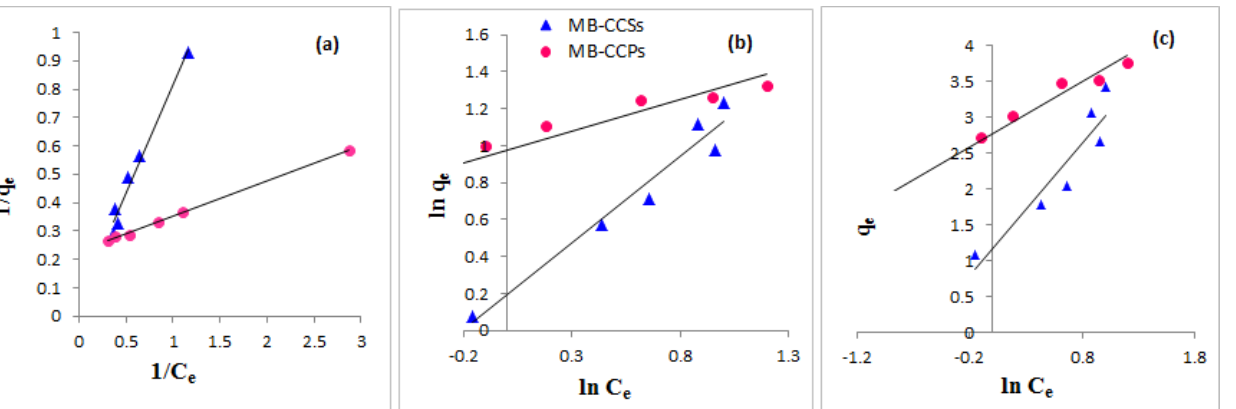
Figure 9. Adsorption Isotherm models: ( a ) Langmuir, ( b ) Freundlich, ( c ) Temkin. By analyzing these results, it was noted that the Langmuir model presented the best fitness for MB-CCSs system pursued by the Freundlich model (R 2 = 0.9753 and R 2 = 0.9503